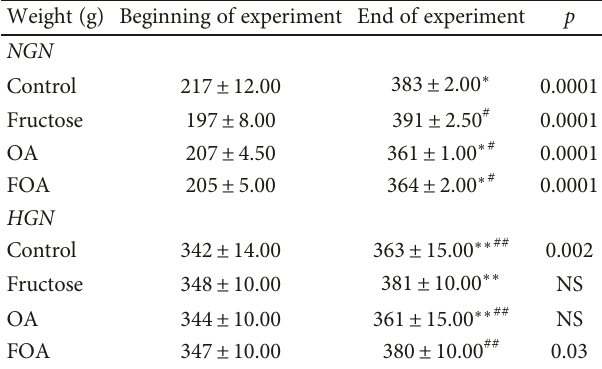
Table 2: Body weight of animal at the start and at the end of